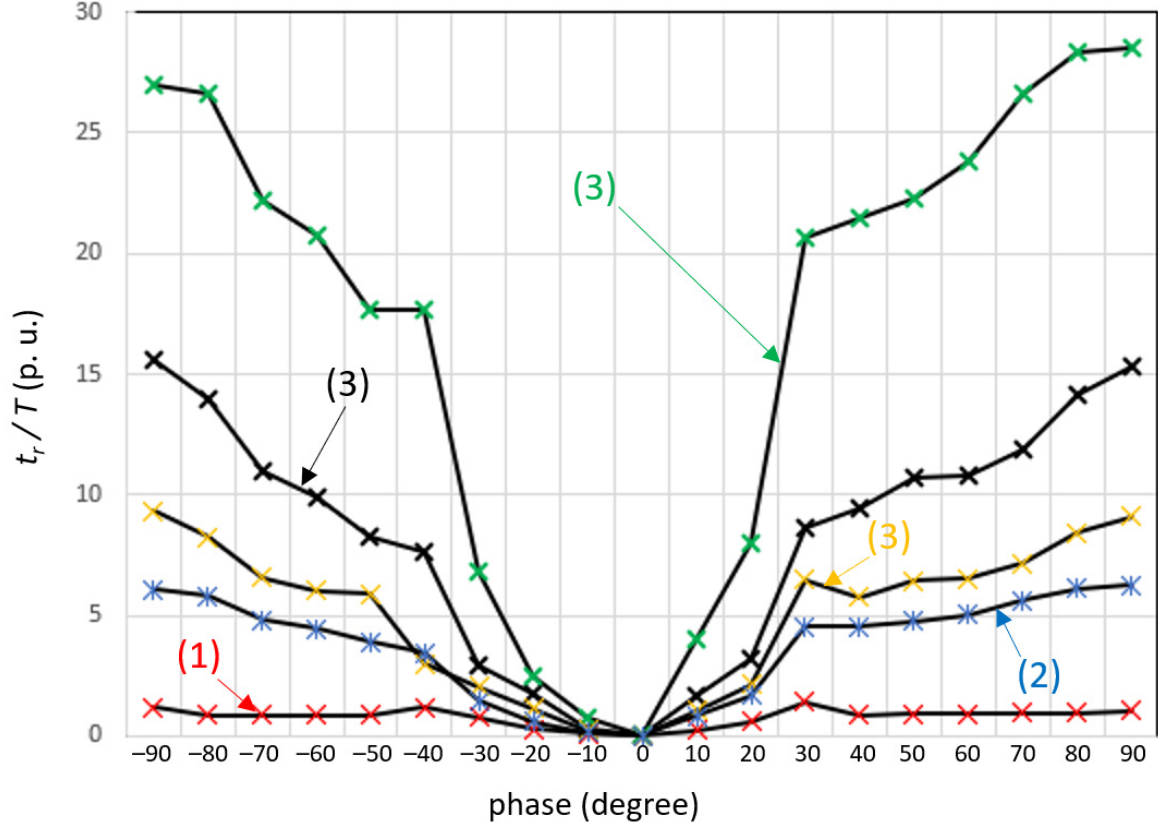
Figure 15. Response time of synchronization systems expressed in fundamental component periods t r / T for phase jumps: (1) proposed method, (2) EPLL method, (3) inverse PLL method, (4) PLL method and (5) T/4 delay method.